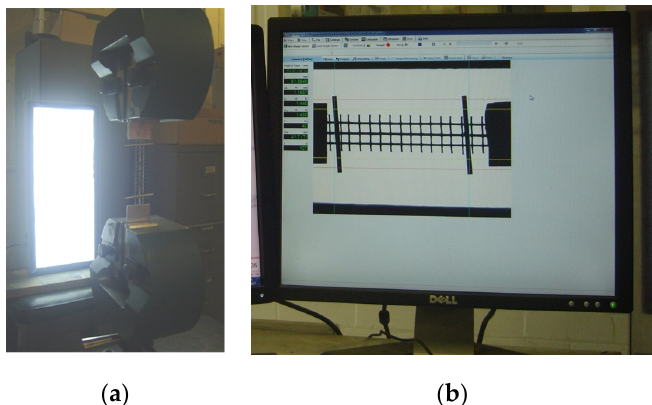
Figure 6. Test of a basalt grid strip using the backlight method: ( a ) specimen during testing and ( b ) software screen view.